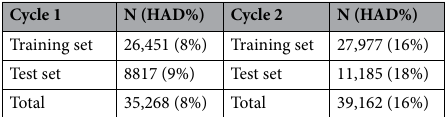
Table 7. Distribution HAD visits in OPD data set.